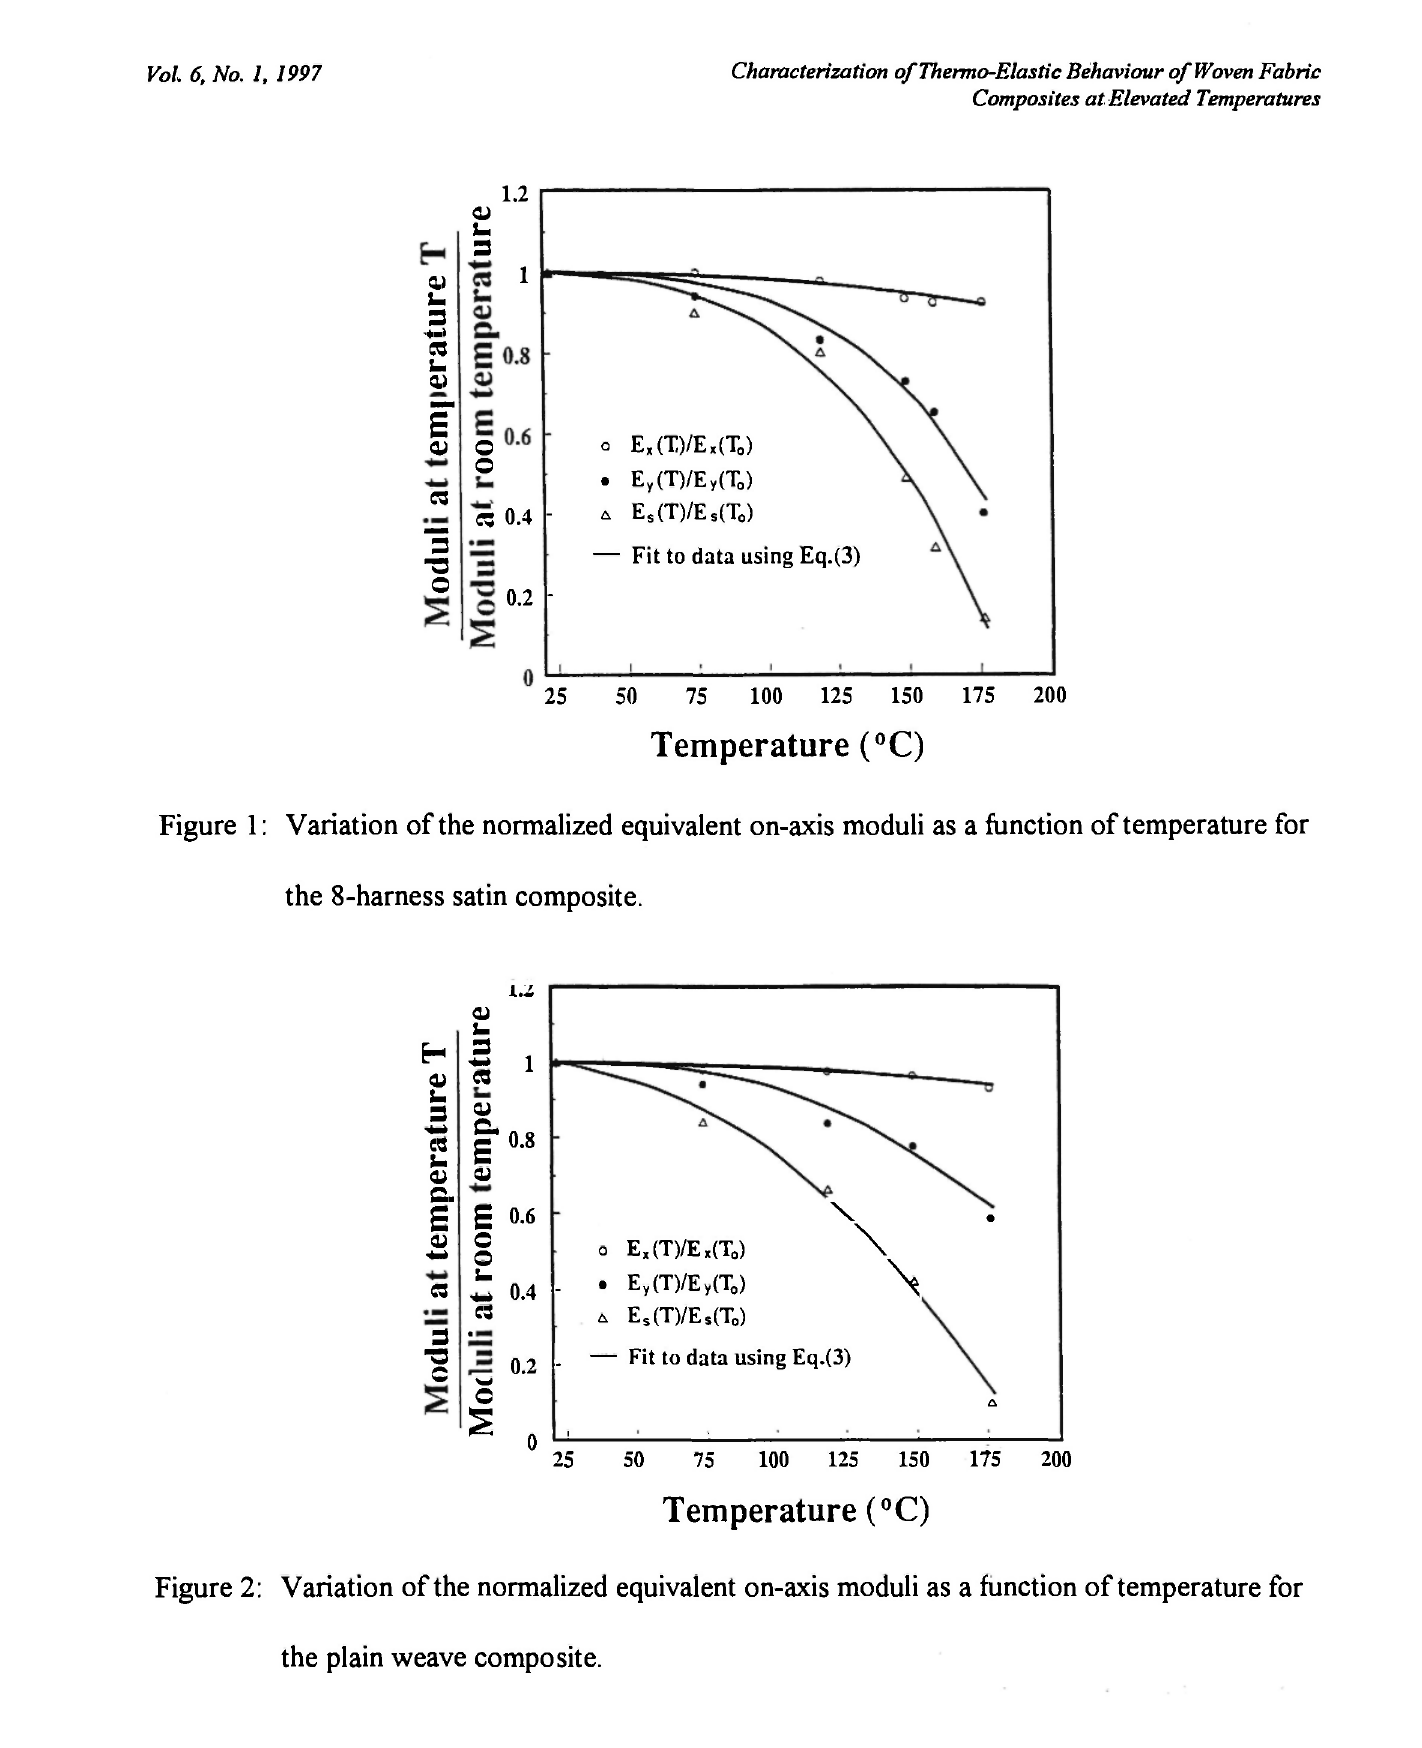
Figure 2: Variation of the normalized equivalent on-axis moduli as a function of temperature for the plain weave